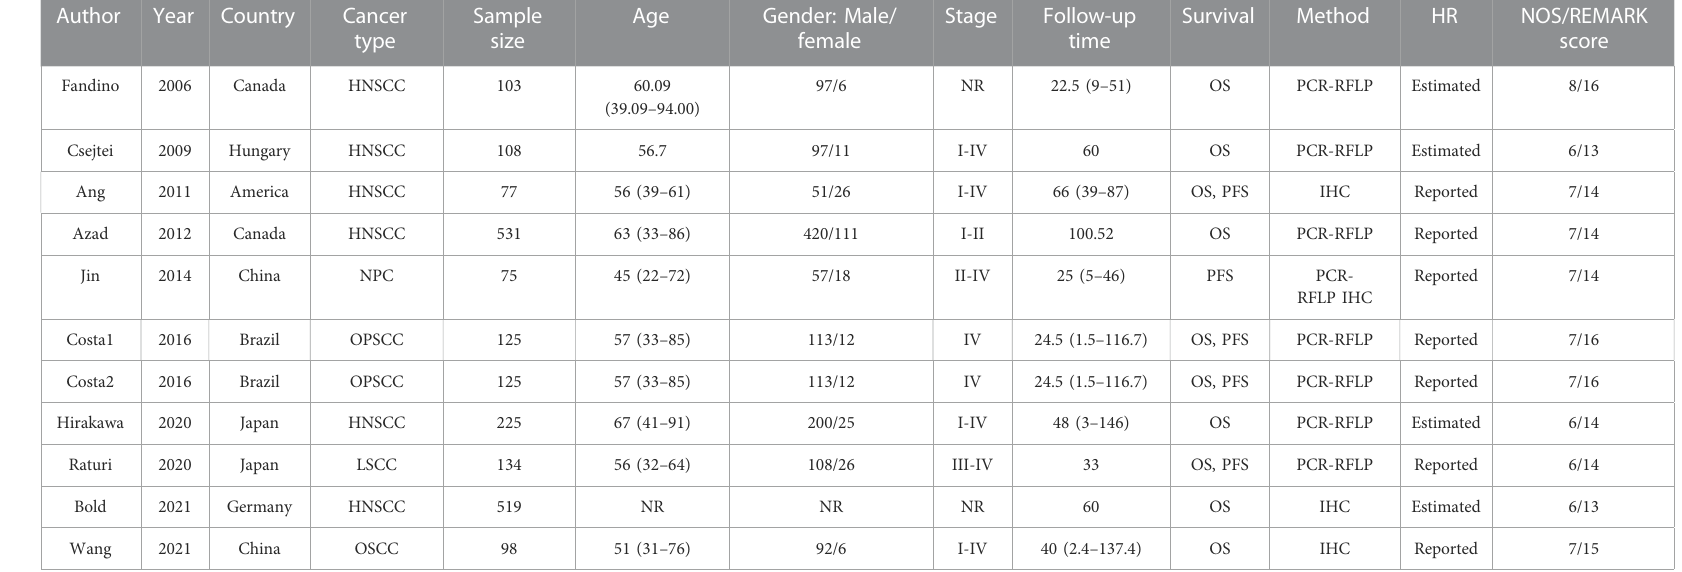
TABLE1Characteristicsofthestudiesincludedinthemeta-analysis.NR,notreported;IHC,Immunohistochemistry;PCR-RFLP,polymerasechainreactionrestrictionfragmentlengthpolymorphism;HNSCC,headand neck squamous cell carcinoma; LSCC, laryngeal squamous cell carcinoma; OSCC, oral squamous cell carcinomas; NPC, nasopharyngeal carcinoma; OPSCC, oropharyngeal squamous cell